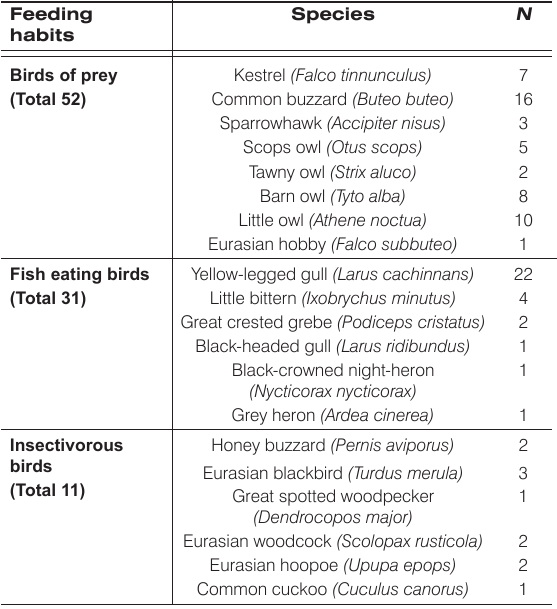
Table 1. Species subdivision according to feeding